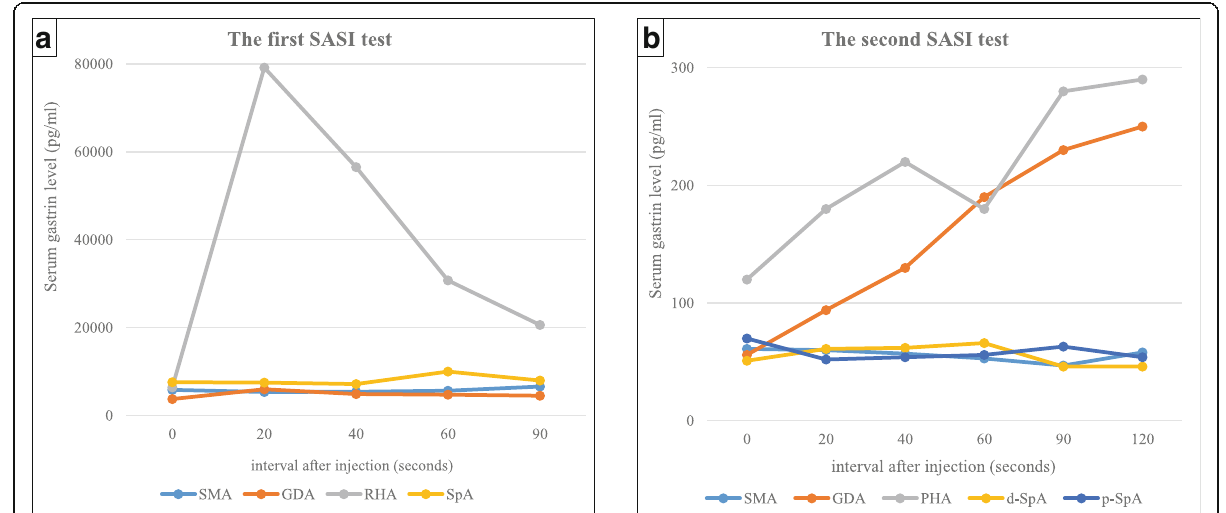
Fig. 2 The selective arterial secretagogue injection test (SASI) test. a The first SASI test showed a significant elevation of the serum IRG level from 6427 to 79,160 pg/mL at 40 s after the stimulation of the right hepatic artery. b The second SASI test showed an elevation of the serum IRG level from 56 to 130 pg/mL at 40 s after the stimulation of the gastroduodenal